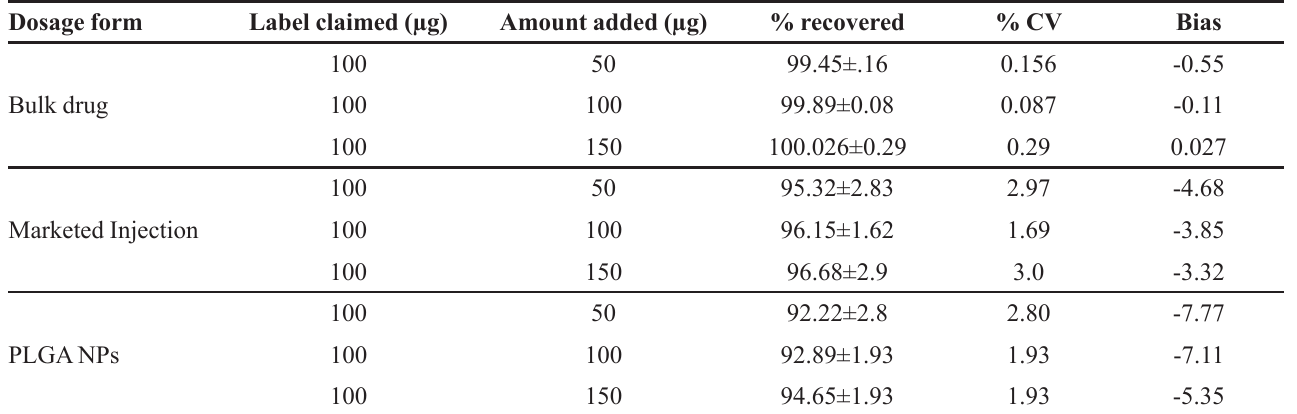
TABLE IV - Accuracy as % recovery (n=3) Dosage form